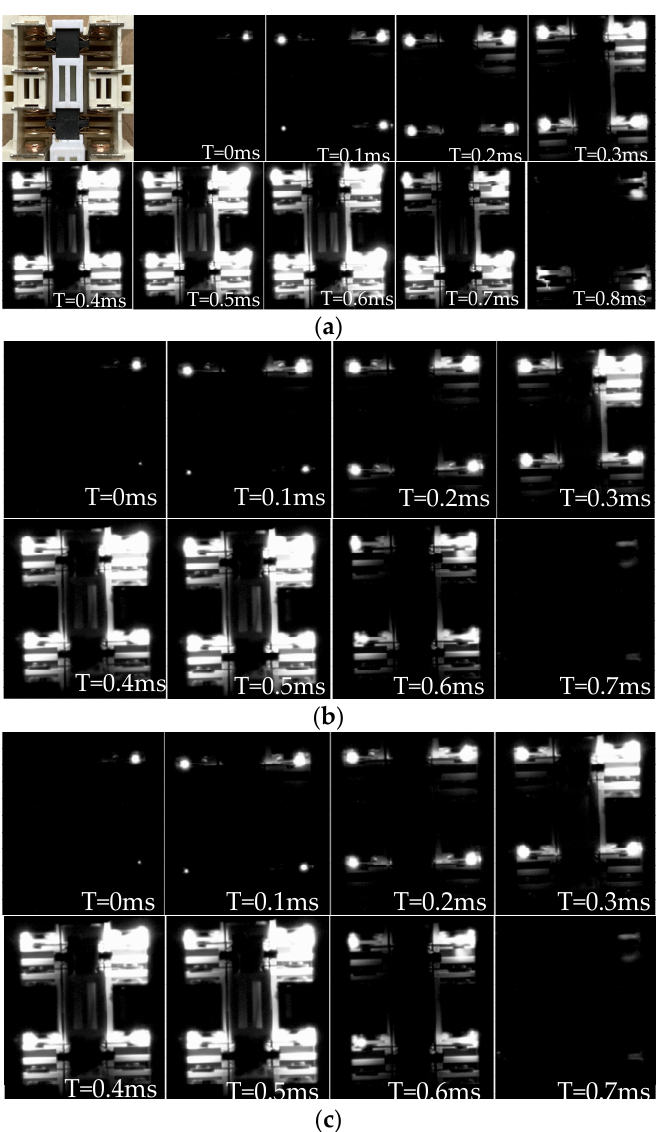
Figure 13. Arc image high-speed photography. ( a ) High-speed photography at different moments under 410 V/13 A, ( b ) High-speed photography at different moments under 240 V/21 A, ( c ) High- speed photography at different moments under 188 V/28 A.